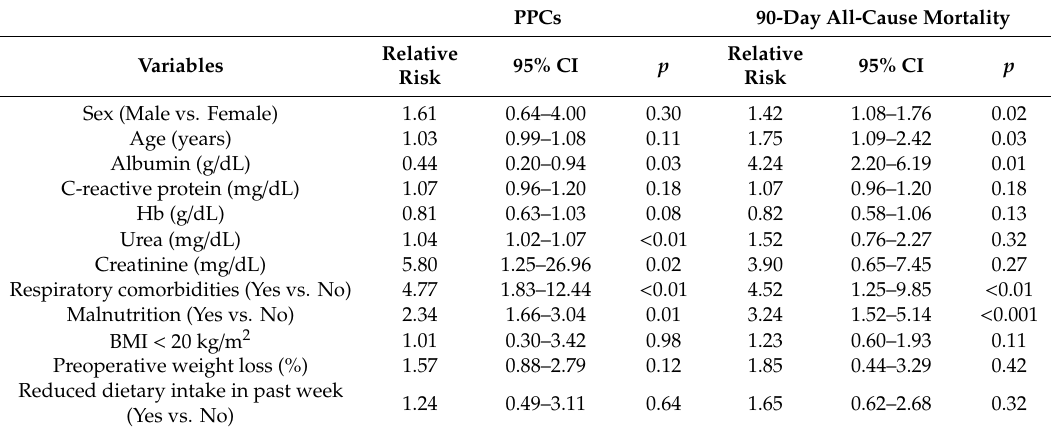
Table 2. Univariate logistic regression analysis of predictive factors associated with postoperative pulmonary complications (PPCs) and 90-day all-cause mortality after major abdominal surgery in patients with